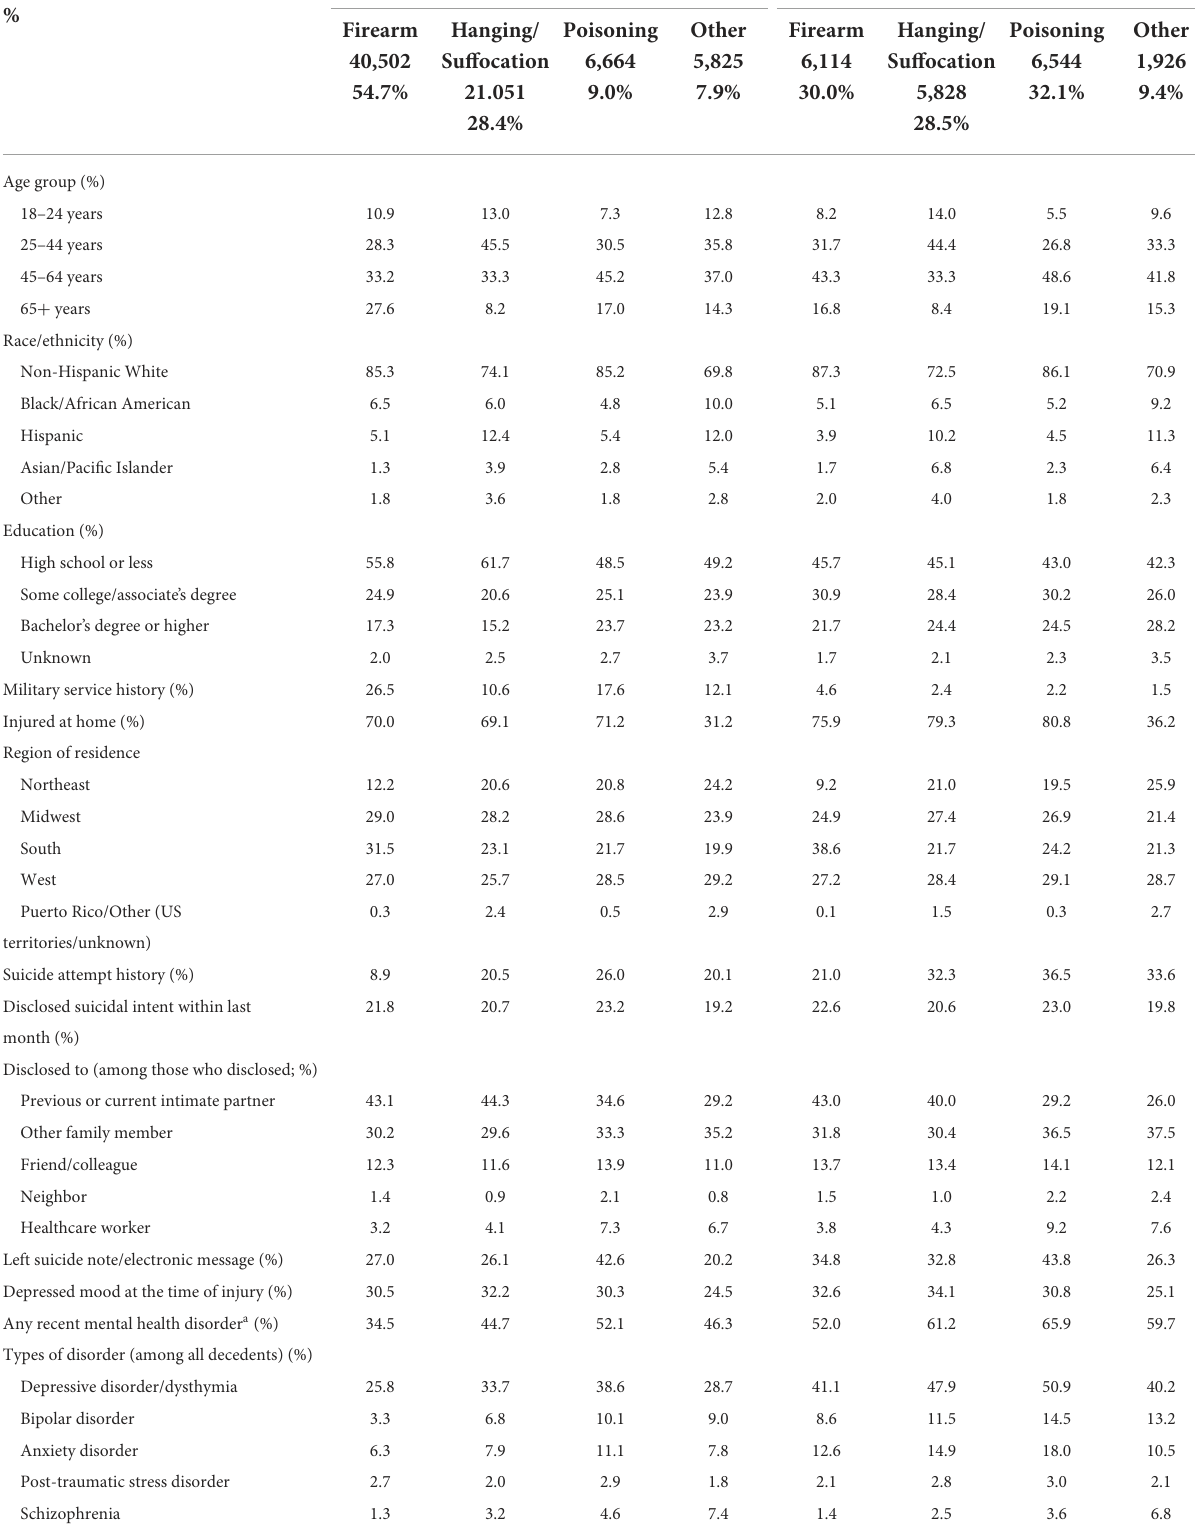
Men ( N = 70,042; 78.4% of both